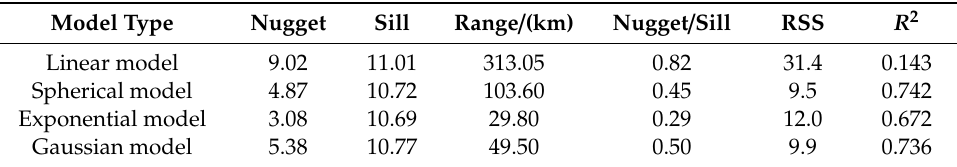
Table 5. Parameters of semivariogram models for vegetation carbon density (including tree, understory vegetation and litter layers) in Pinus massoniana forest in the Jiangxi Province.